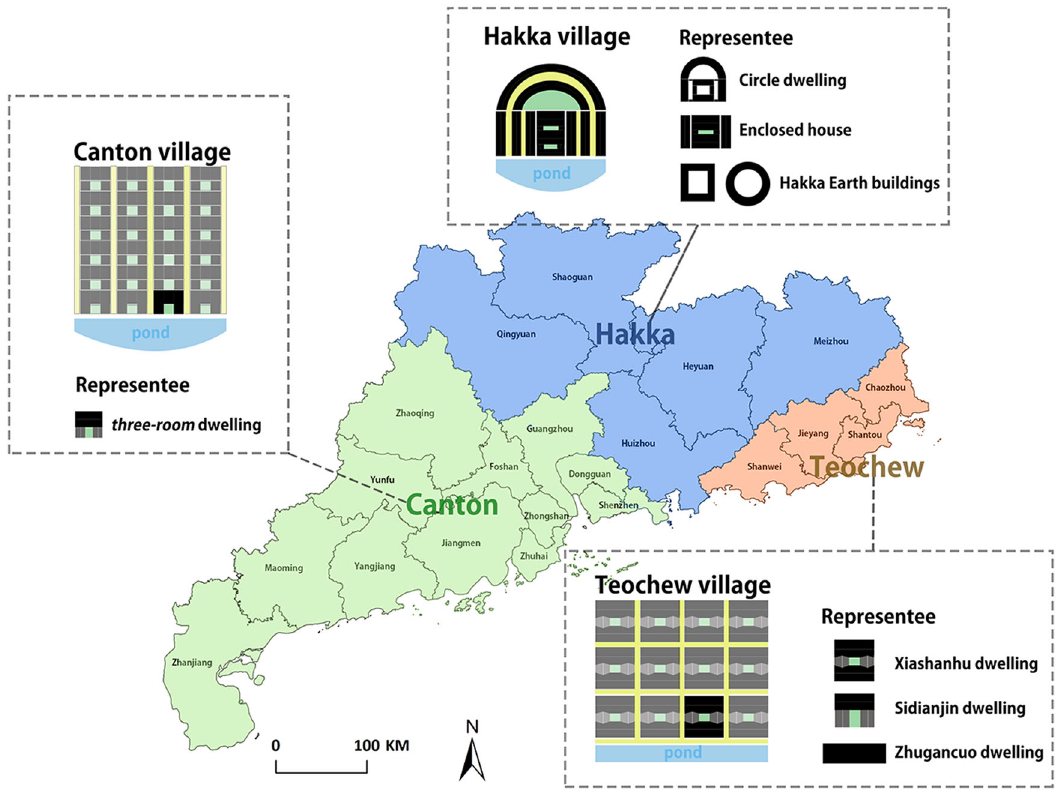
Fig. 1 Approximate distribution of three major ethnic groups in Guangdong, China based on conventional surveys and fi eld studies. Three bounding boxes show their classic footprints of the building layouts and the representees according to domain